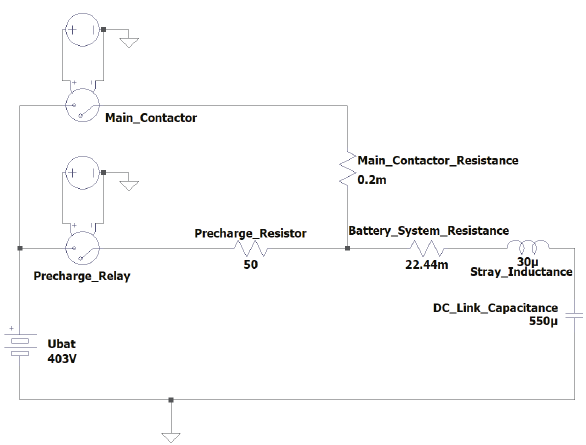
Fig. 1. Simulation circuit with